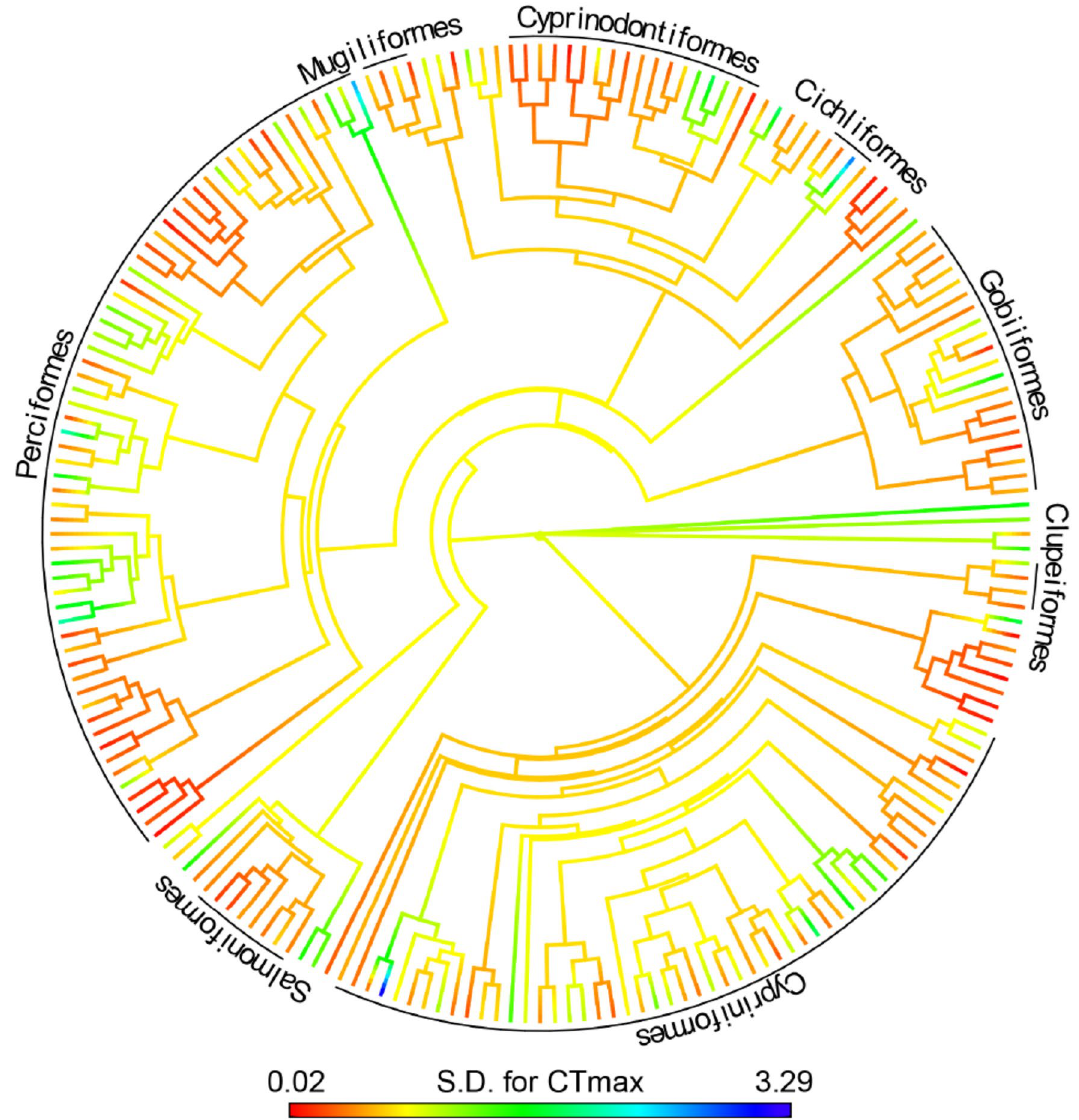
Figure 4. Phylogenetic tree of 203 species and their families, organised according to their intraspecific variation in upper thermal tolerance, estimated as the standard deviation of their CT max (S.D. for CT max